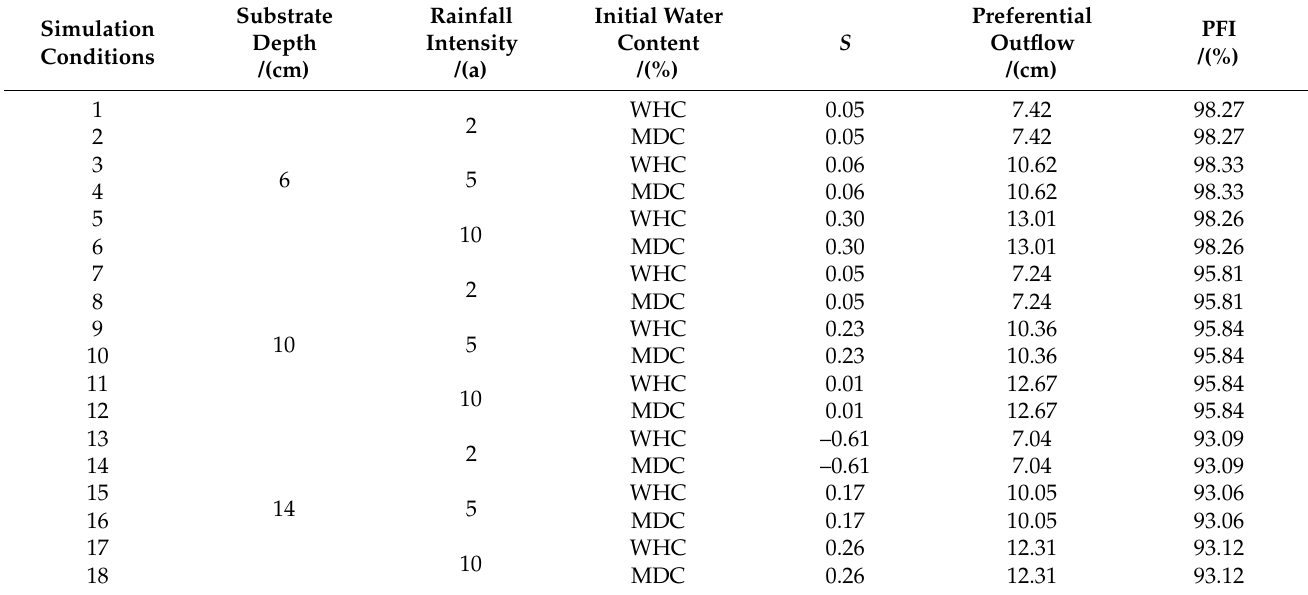
Table 11. Simulation results of VAS under different simulation conditions.